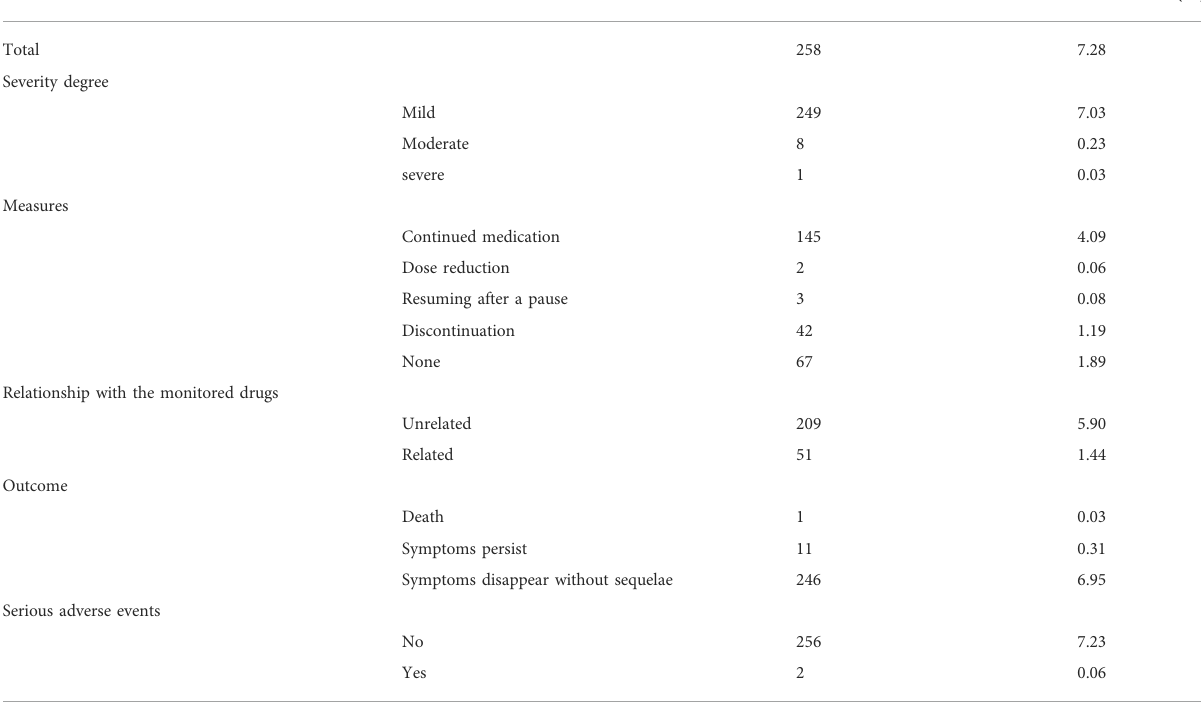
TABLE 3 Summary of adverse events in the SS.